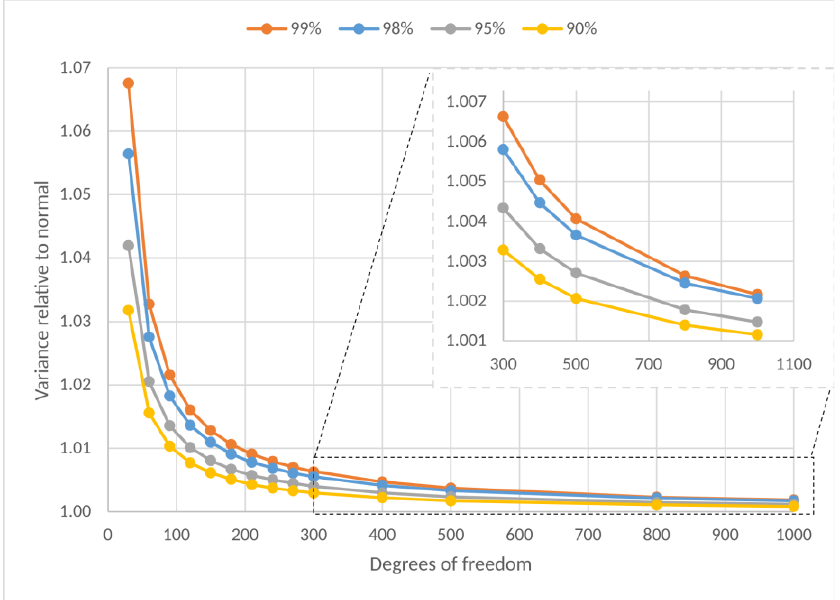
Figure 9. Variation of Student parameters with degrees of freedom ( M − 1) under various probabilities starting at M = 30 and for groups starting at M = 300 (detail).